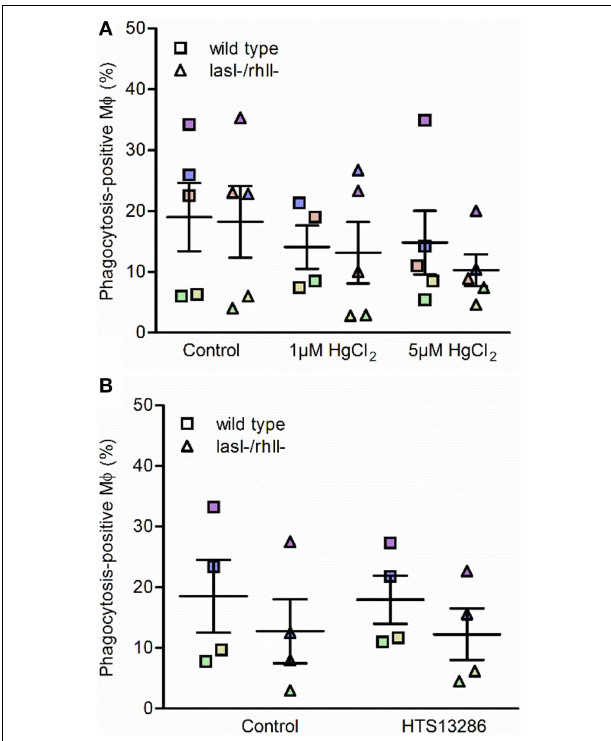
FIGURE 7 | Effect of water fluxes inhibitors on phagocytosis of P. aeruginosa by macrophages. Macrophages were pretreated with (A) 1 or 5 µ M HgCl 2 , or PBS as a control; (B) 25 µ M HTS13286 or 0.25% DMSO as vehicle control for 20min. Wild type P. aeruginosa or the lasI-/rhlI- mutant at MOI 10 were added for 1h of infection and phagocytic activity of macrophages were evaluated. Shown are the mean ± SE of the percentage of phagocytosis-positive macrophages. Data are from individual independent experiments performed at separate days from 4 to 5 different donors (color